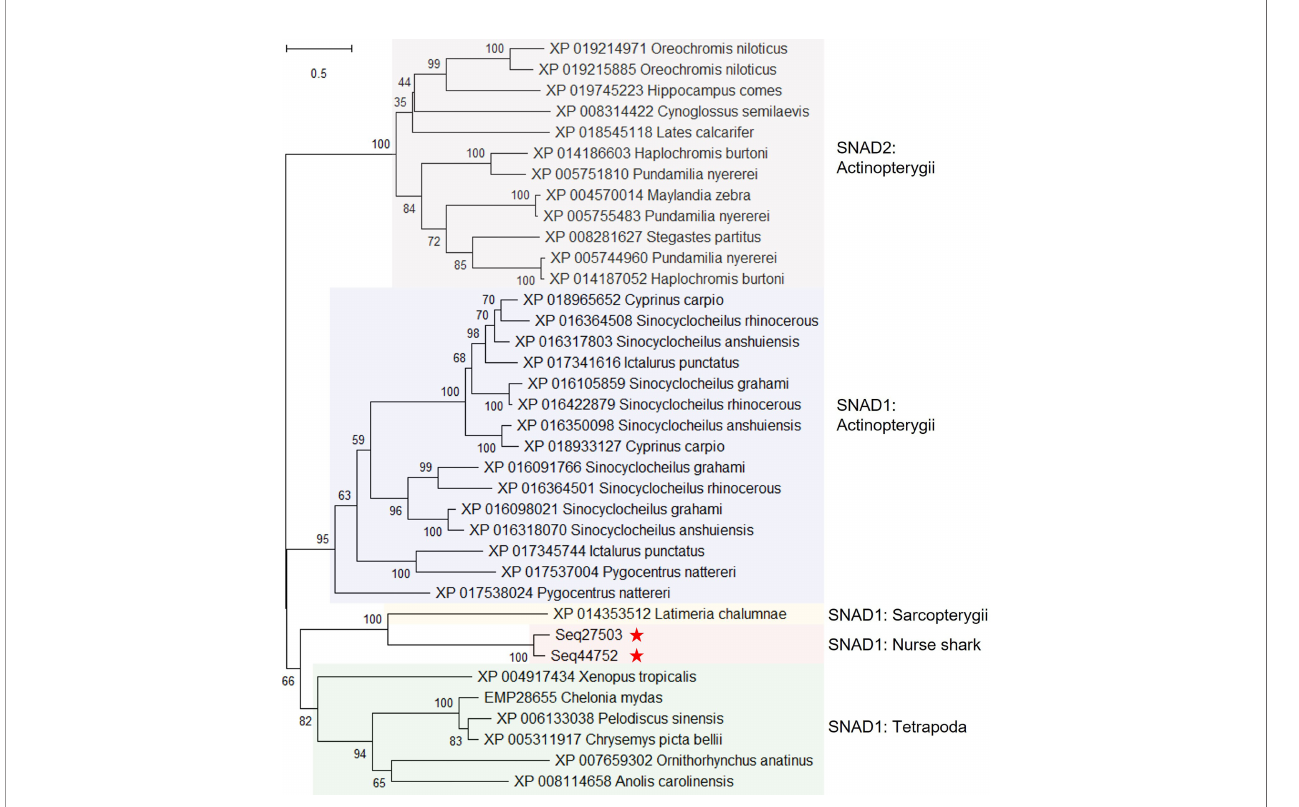
FIGURE 2 | Maximum likelihood consensus tree of selected SNAD1 and SNAD2 sequences from 49, and predicted proteins from nurse shark contigs Seq27503 and Seq44752. The tree, which is rooted to the SNAD2 clade, was generated using the best fi tting amino acid substitution model (WAG+F+I+G4) and includes branch support values from 1,000 ultrafast bootstrap